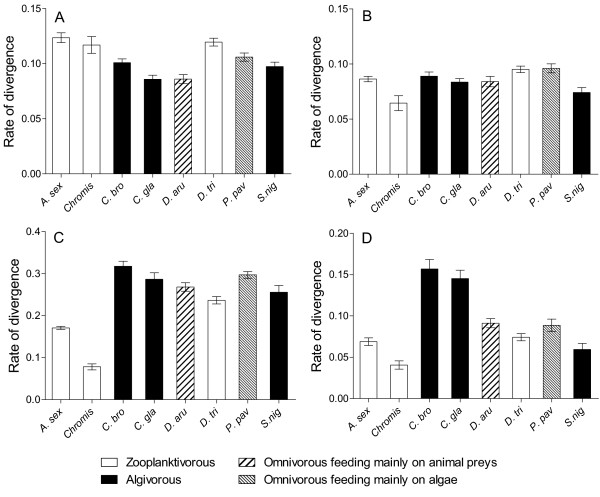
Dynamics of shape changes. (A) Neurocranium, (B) «suspensorium and opercle» unit, (C) mandible and (D) premaxilla. Rates of divergence (Mean ± Standard error) away from the larval shape, estimated by the regression of the Procrustes distance between each specimen and the average larval form of its species on log-transformed centroid size. The rates are expressed as the amount of shape changes per unit of size. The diet of each species is illustrated by patterned bars. See Table 1 for abbreviations of the species.